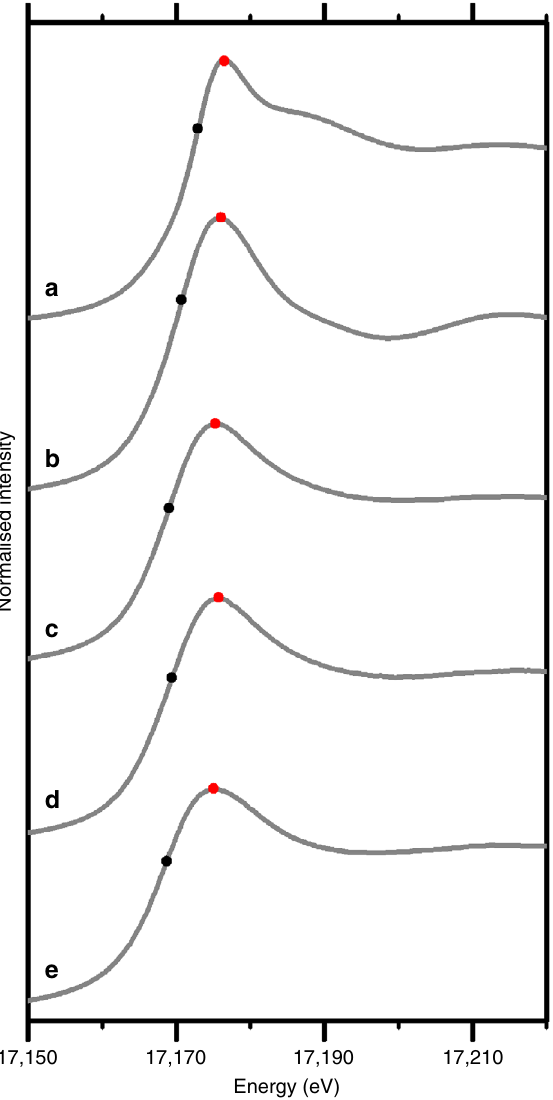
Fig. 6 Uranium L III -edge XANES spectra. a U(VI)-standard, b U(IV)- standard, c complex 4 , d complex 3 , and e [UI 3 (THF) 4 ]. Black dots mark the point where the second derivative of that XANES spectrum crosses zero (edge). Red dots indicate the position of the primal spectral XANES peak energy (white line) for that spectrum (where fi rst derivative of the XANES trace crosses zero). The estimated uncertainty is ±0.2